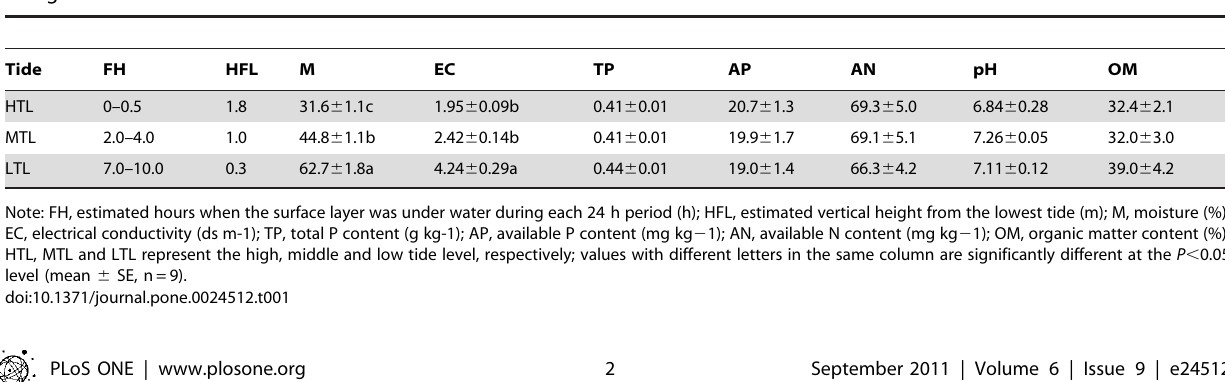
Table 1. Hydrological conditions and the properties of rhizosphere soil at the high, middle and low tide levels in the Zhuhai Mangrove